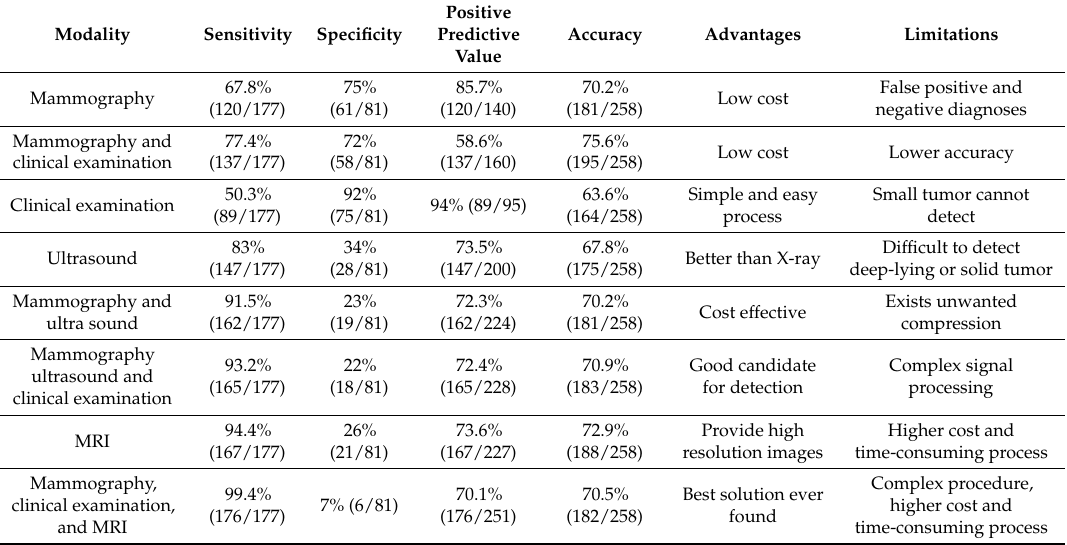
Table 1. Comparison of Diagnostic Performance of different breast tumour detection techniques